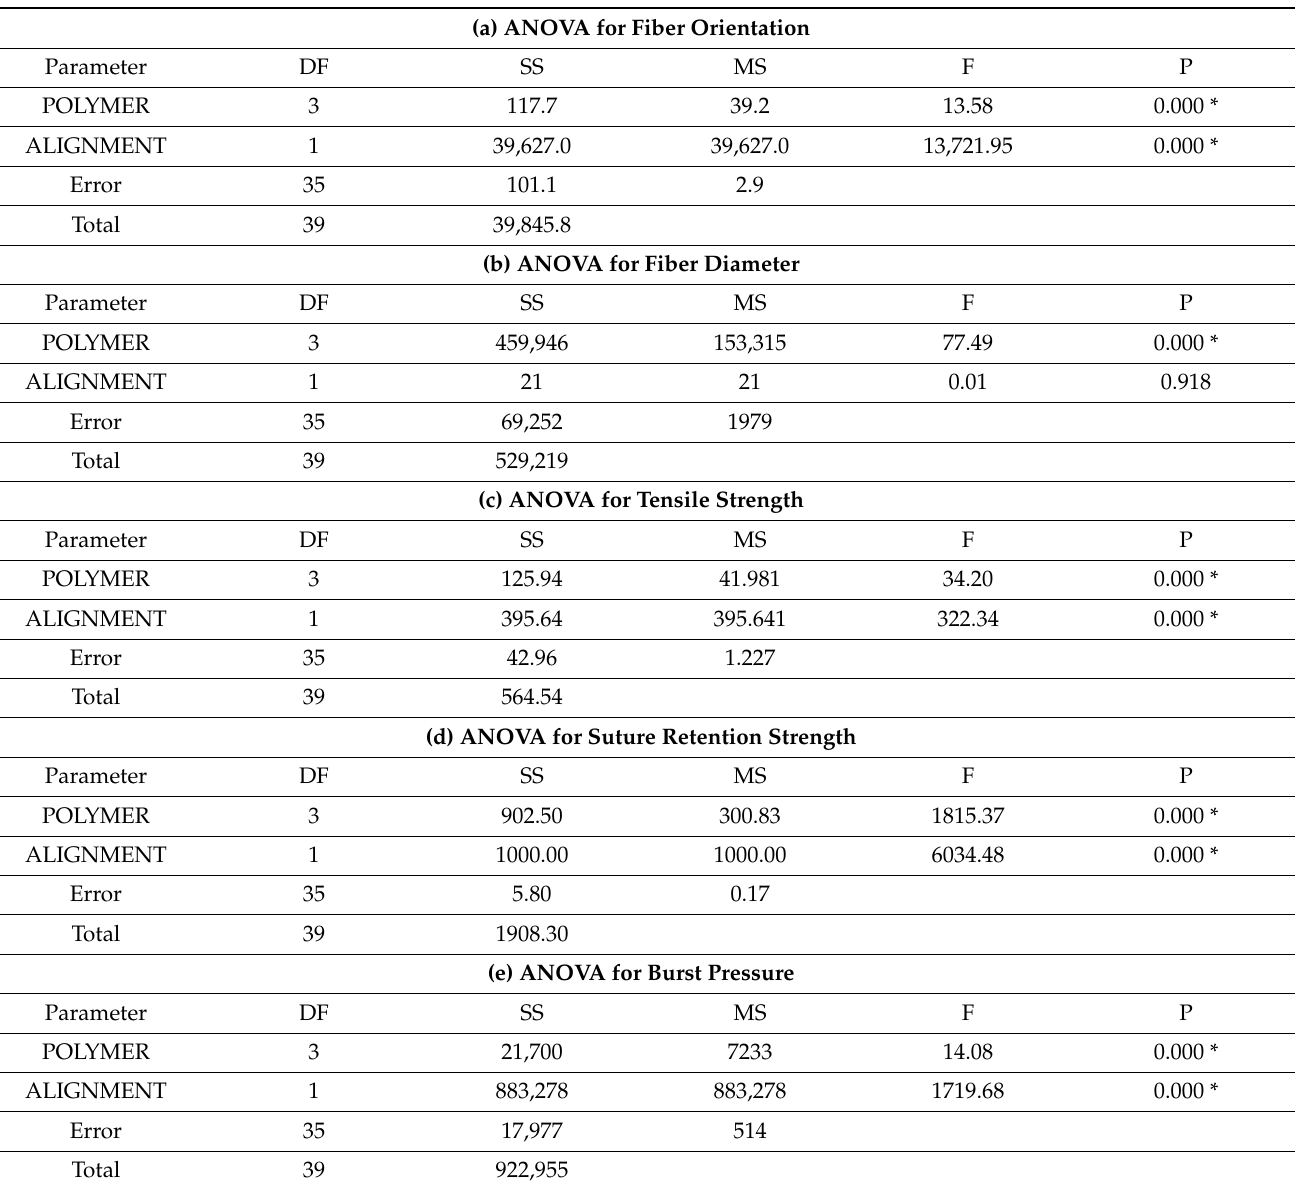
Table 1. Analysis of Variance (ANOVA) for different response